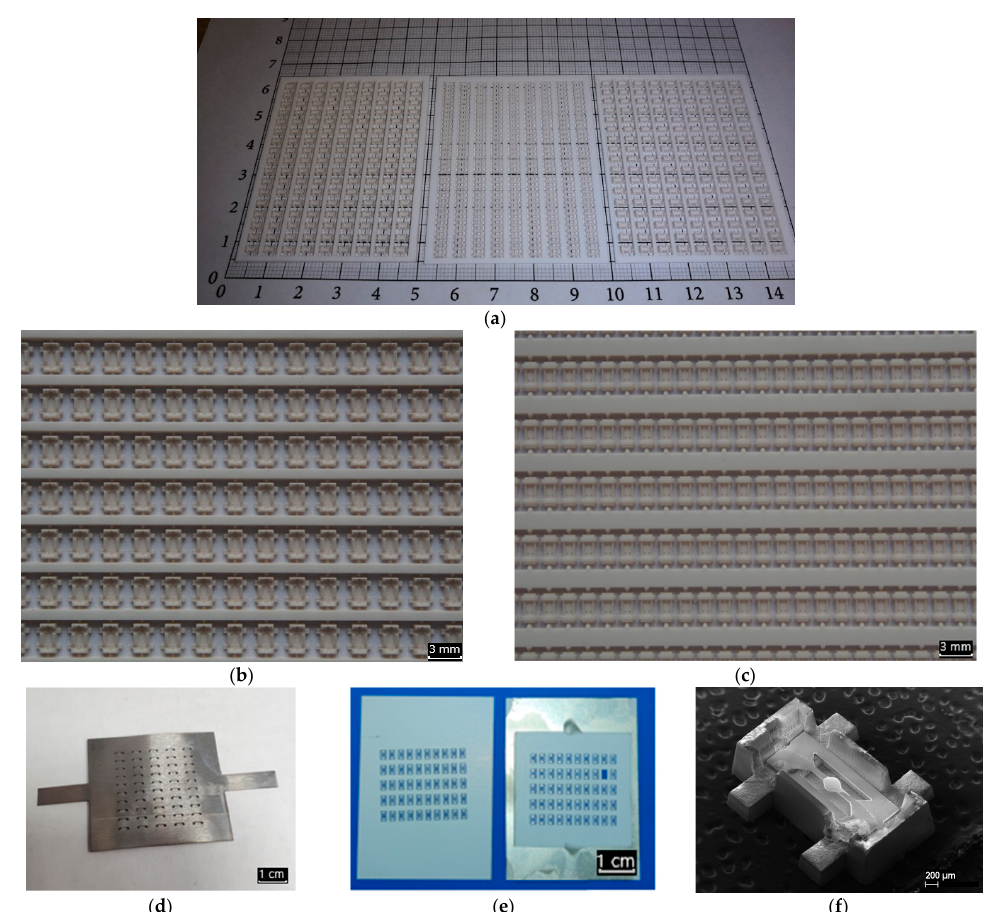
Figure 5. Scaling of laser micromachining fabrication of MOX sensor packages and 3YSZ microhotplates: ( a ) Three ceramic substrates containing a maximum density of SOT-23 packages parts—in the middle, a 0.5 × 60 × 48 mm 3 substrate containing frame 9 × 35 = 315 pcs. caps of package and on the outside, 1.0 × 60 × 48 mm 3 substrates containing each frame 9 × 17 = 153 pcs. (total for two substrate 306 pcs.) bottom of the package; ( b ) magnified optical image of the package bottoms on a ceramic frame from the middle substrate on ( a ); ( c ) the magnified optical image of the package bottoms on a ceramic frame from outside substrates on ( a ); ( d ) shadow mask for Pt vacuum sputtering fabricated by laser cutting in the same process as 3YSZ membranes; ( e ) 3YSZ membranes (30 × 48 mm 2 ) after laser cutting on 50 pcs. single chips for microhotplates (left) and one after process of shadow mask Pt vacuum sputtering(right); and ( f ) SEM image of MOX sensor before final gluing the cap of